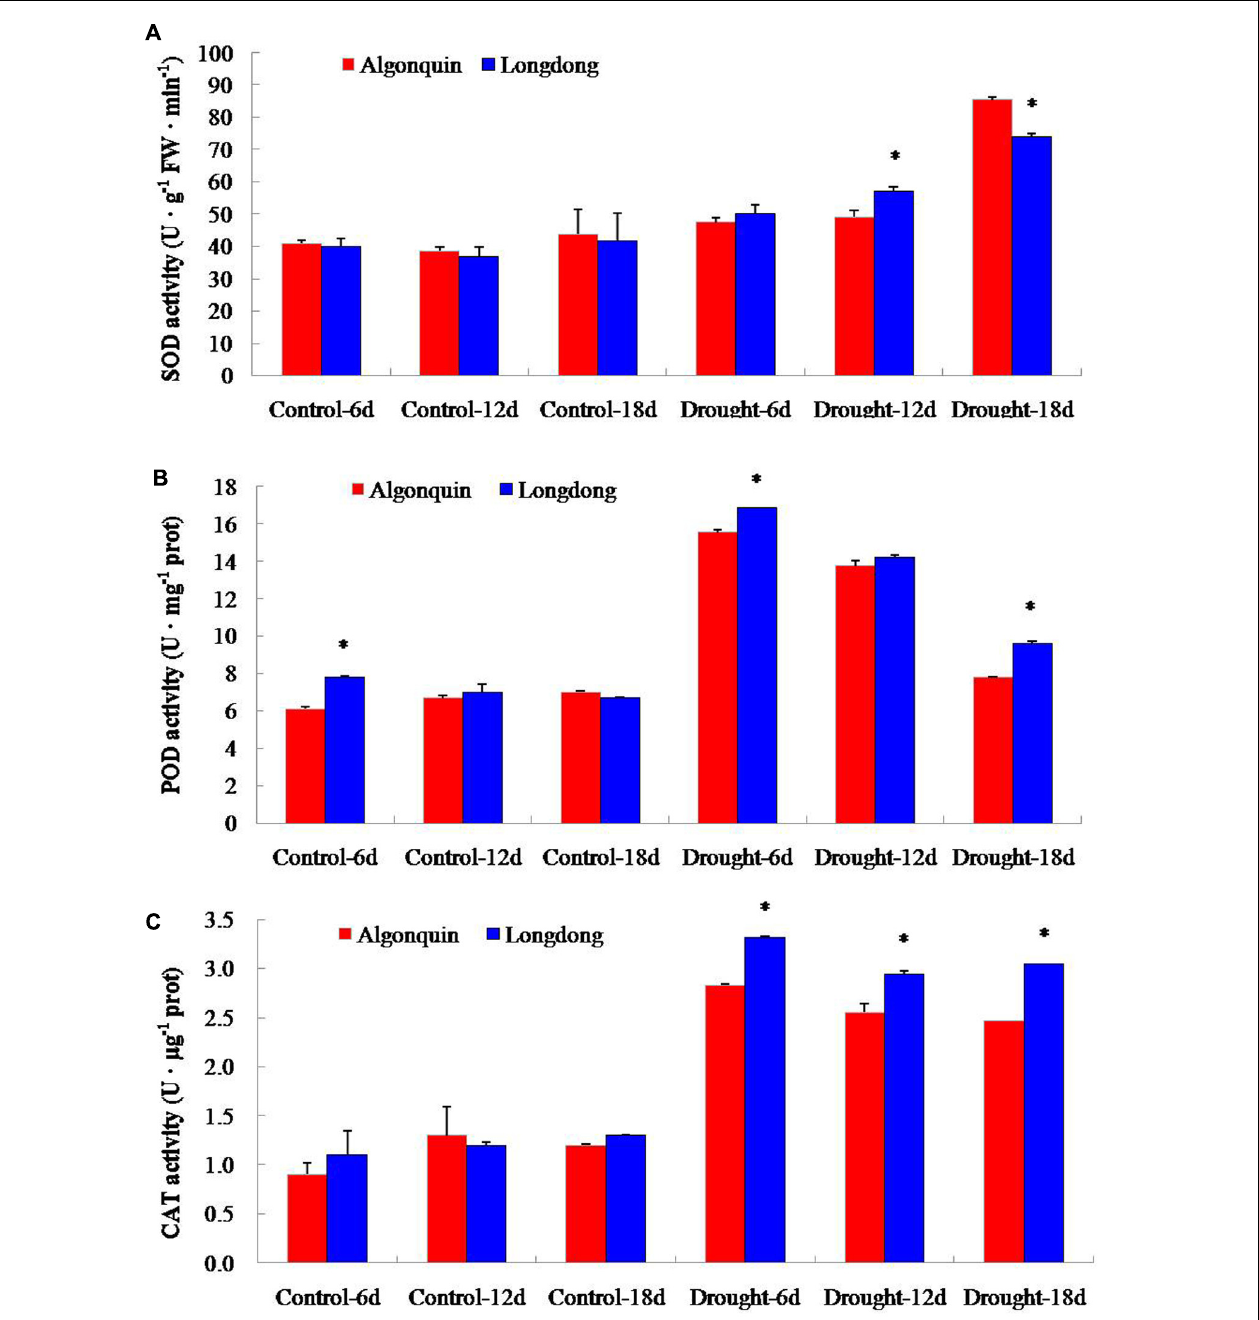
FIGURE 8 | Effect of drought stress on antioxidant enzyme activities. (A–C) SOD, POD, and CAT activities of two varieties during drought stress. The results shown are means ± SE ( n = 3). Asterisk symbols indicate significant differences from Algonquin at P < 0.05 (Student’s t